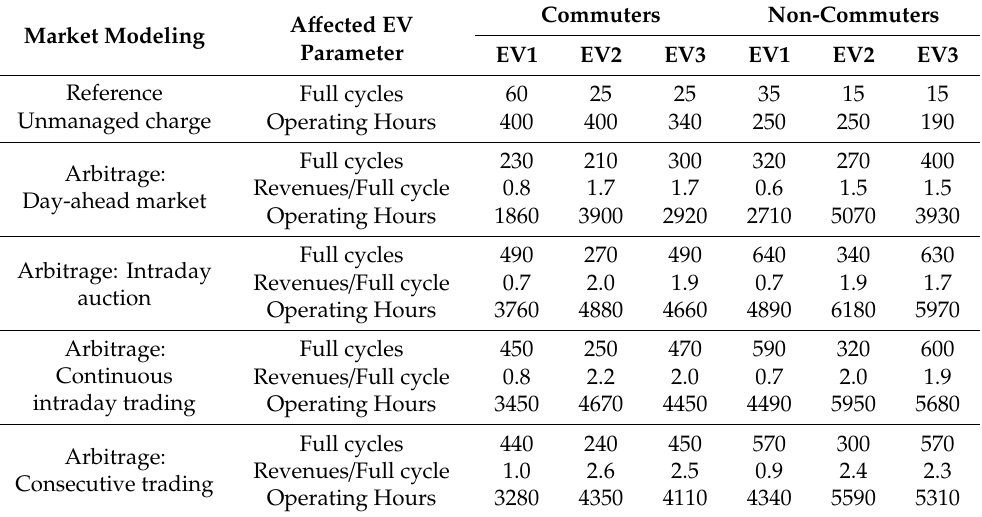
Table 5. Impact of V2G use cases on EV’s full cycles, revenues per full cycle and operating hours. A ff ected Market Modeling